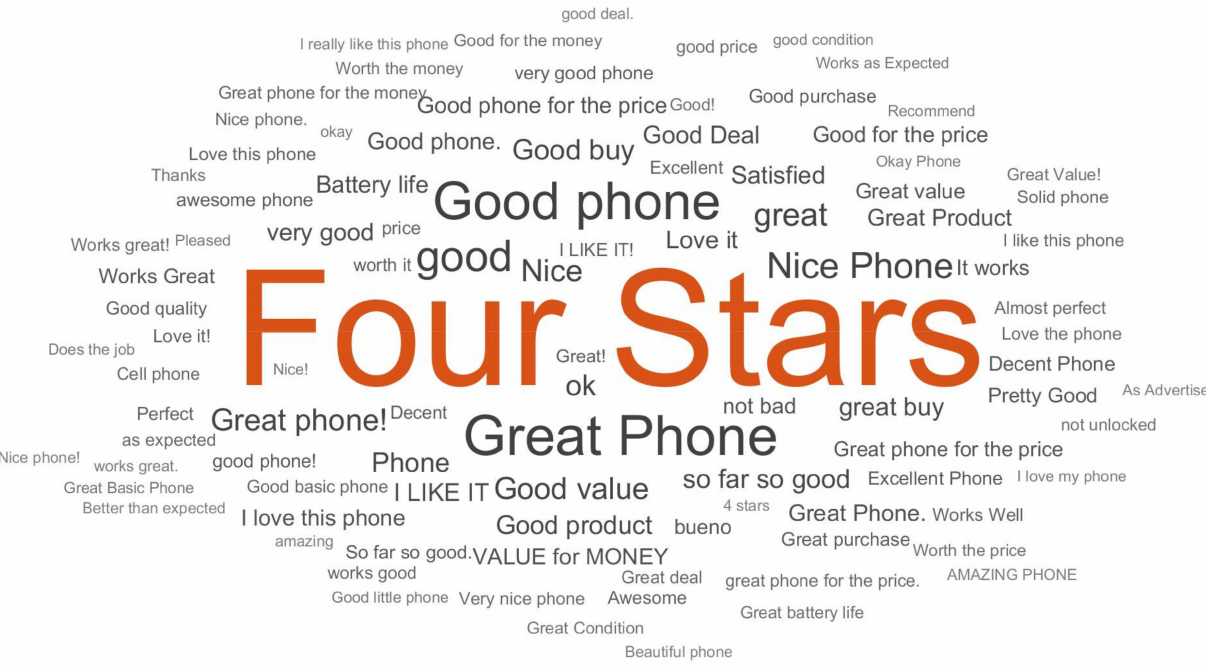
Figure 17. Word-cloud plot analysis for words with review score